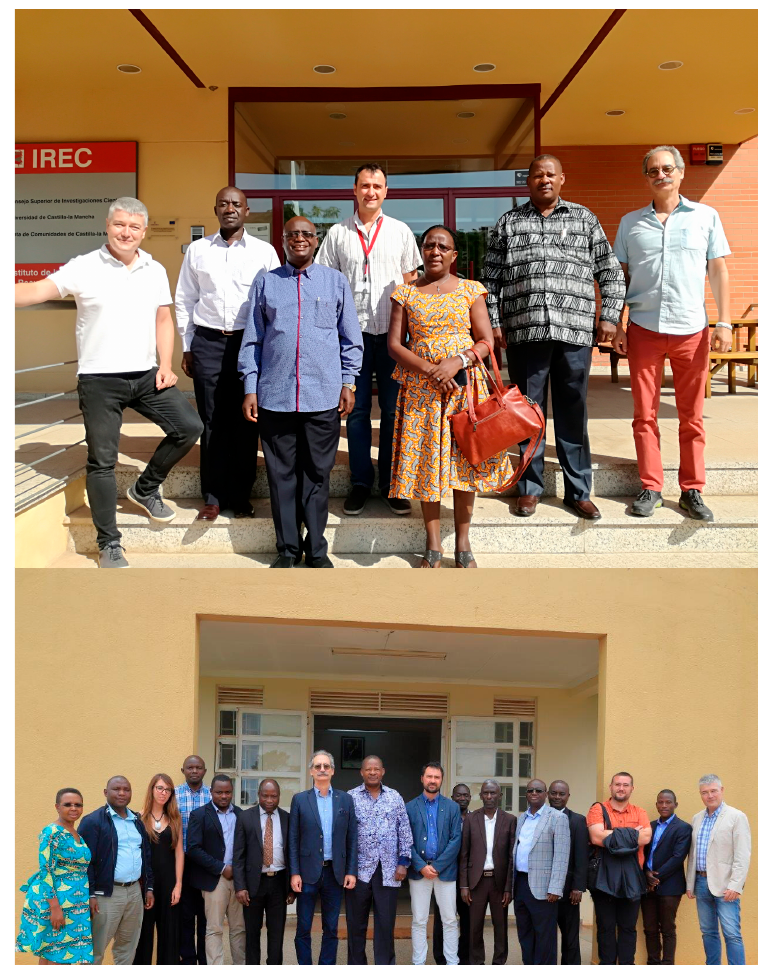
Figure 1. Upper panel: visit of the National Agricultural Research Organization of Uganda (NARO) executives to the Institute of Game and Wildlife Research (IREC) in Ciudad Real, Spain in September 2018. From left to right, C. Gortazar, F. Kabi, J. Rutaisire, R. Mateo, M.T. Kiggundu, A. Agona, and J. de la Fuente. Lower panel: The participants at the meeting between IREC representatives and NARO authorities regarding the development of vaccines for the control of cattle ticks in Uganda. The meeting was held at the National Livestock Resources Research Institute (NaLIRRI) in Wakiso District, Uganda on September 5, 2019. From left to right, I. Kasaija, S. Mugerwa, M.